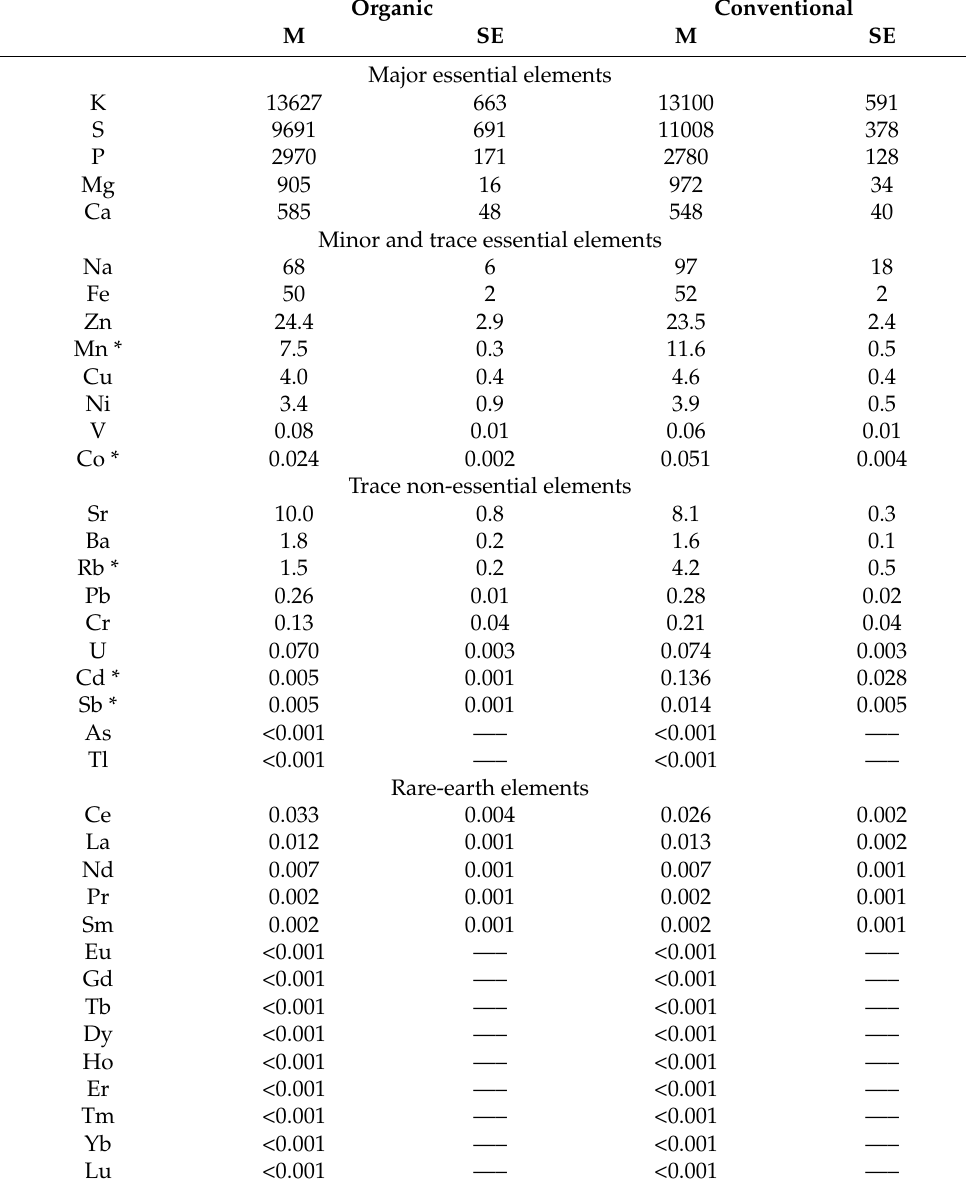
Table 1. Mean (M) concentration and standard error (SE) (mg/kg dw) of major, minor, trace, and rare-earth elements measured in elephant garlic bulbs cultivated organically and conventionally in Valdichiana. * = statistically significant ( p < 0.05)